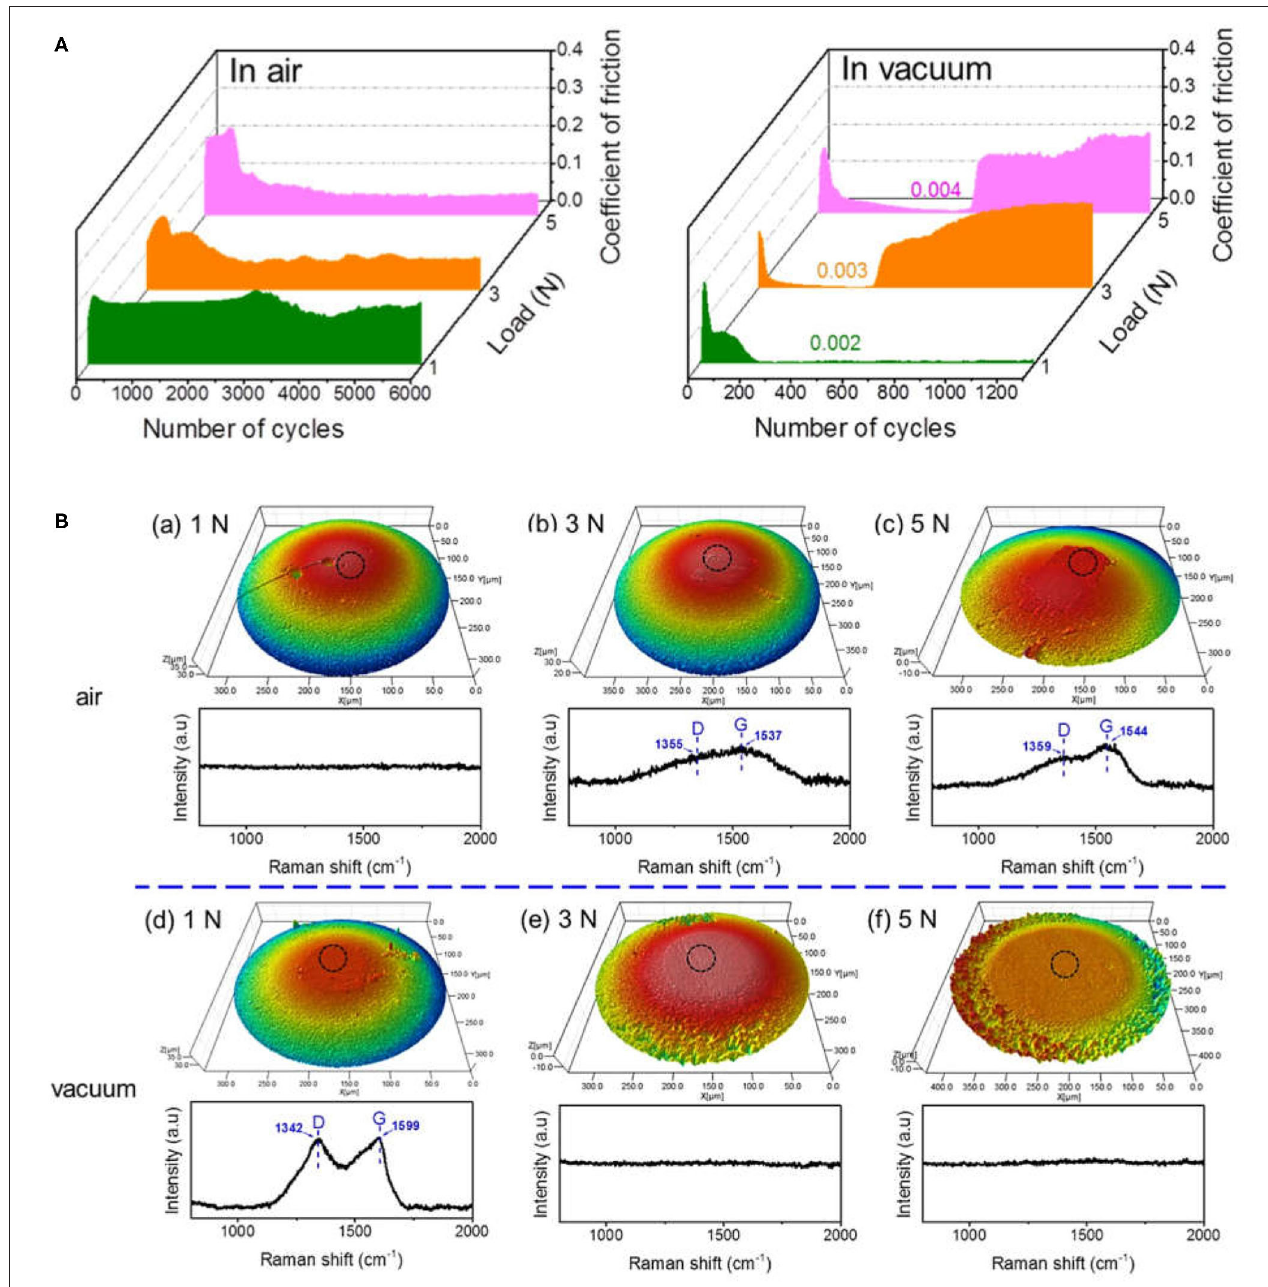
FIGURE 8 | (A) Friction coefficient between a-C:H and Al 2 O 3 in air and vacuum with different normal loads. (B) The wear scars of the ball surfaces after the tribo-testing and their Raman characterization. Adapted with permission from Liu Y. et al. (2019) Copyright 2019, the authors.